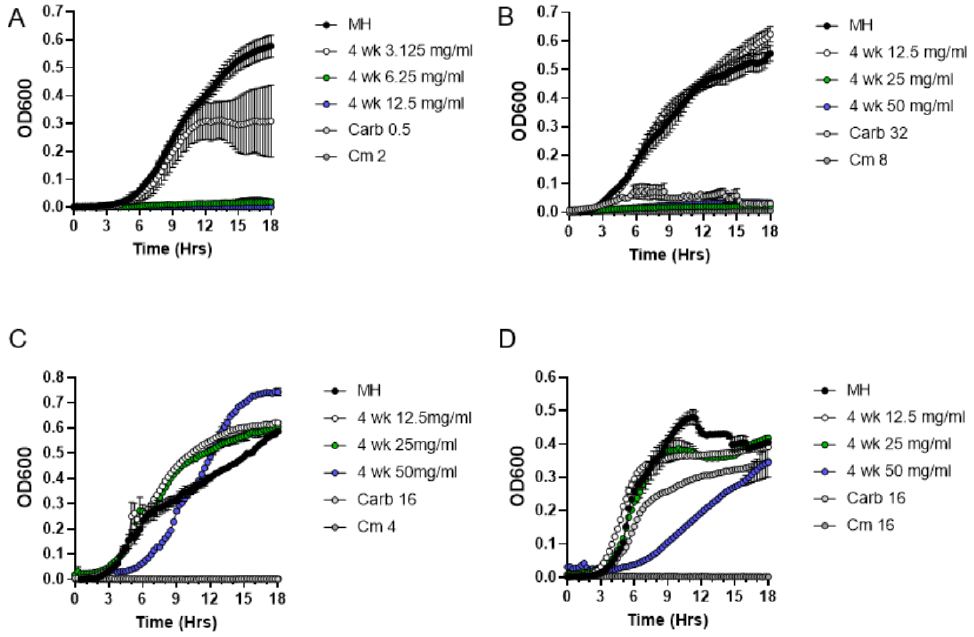
Figure 5. Antibacterial activity (MIC assay) of P. patens exudate from four-week-old Gd strain against Gram-positive and Gram-negative bacteria . Growth curve of Streptococcus pyogenes ( A ), Enterococcus faecium ( B ) , Salmonella Typhimurium ( C ) and Serratia marcescens ( D ) cells was monitored in the presence of different concentrations of P. patens exudate solution. MH — negative control with untreated bacterial cultures grown in Mueller – Hinton broth medium. Different concentrations (in μg /mL) of carbenicillin (Carb) and chloramphenicol (Cm) were used as positive controls for bacterial growth inhibition.